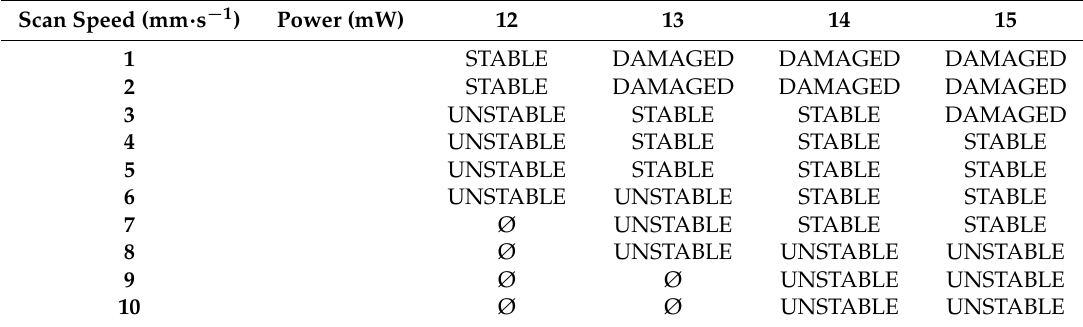
Table 2. Optimization of the scan speed (mm · s − 1 ) and laser power (mW) resulting in the process window for the microfabrication of niches. STABLE = structurally stable niches; UNSTABLE = structurally unstable niches; DAMAGED = structurally damaged niches; Ø = no polymerization occurred.